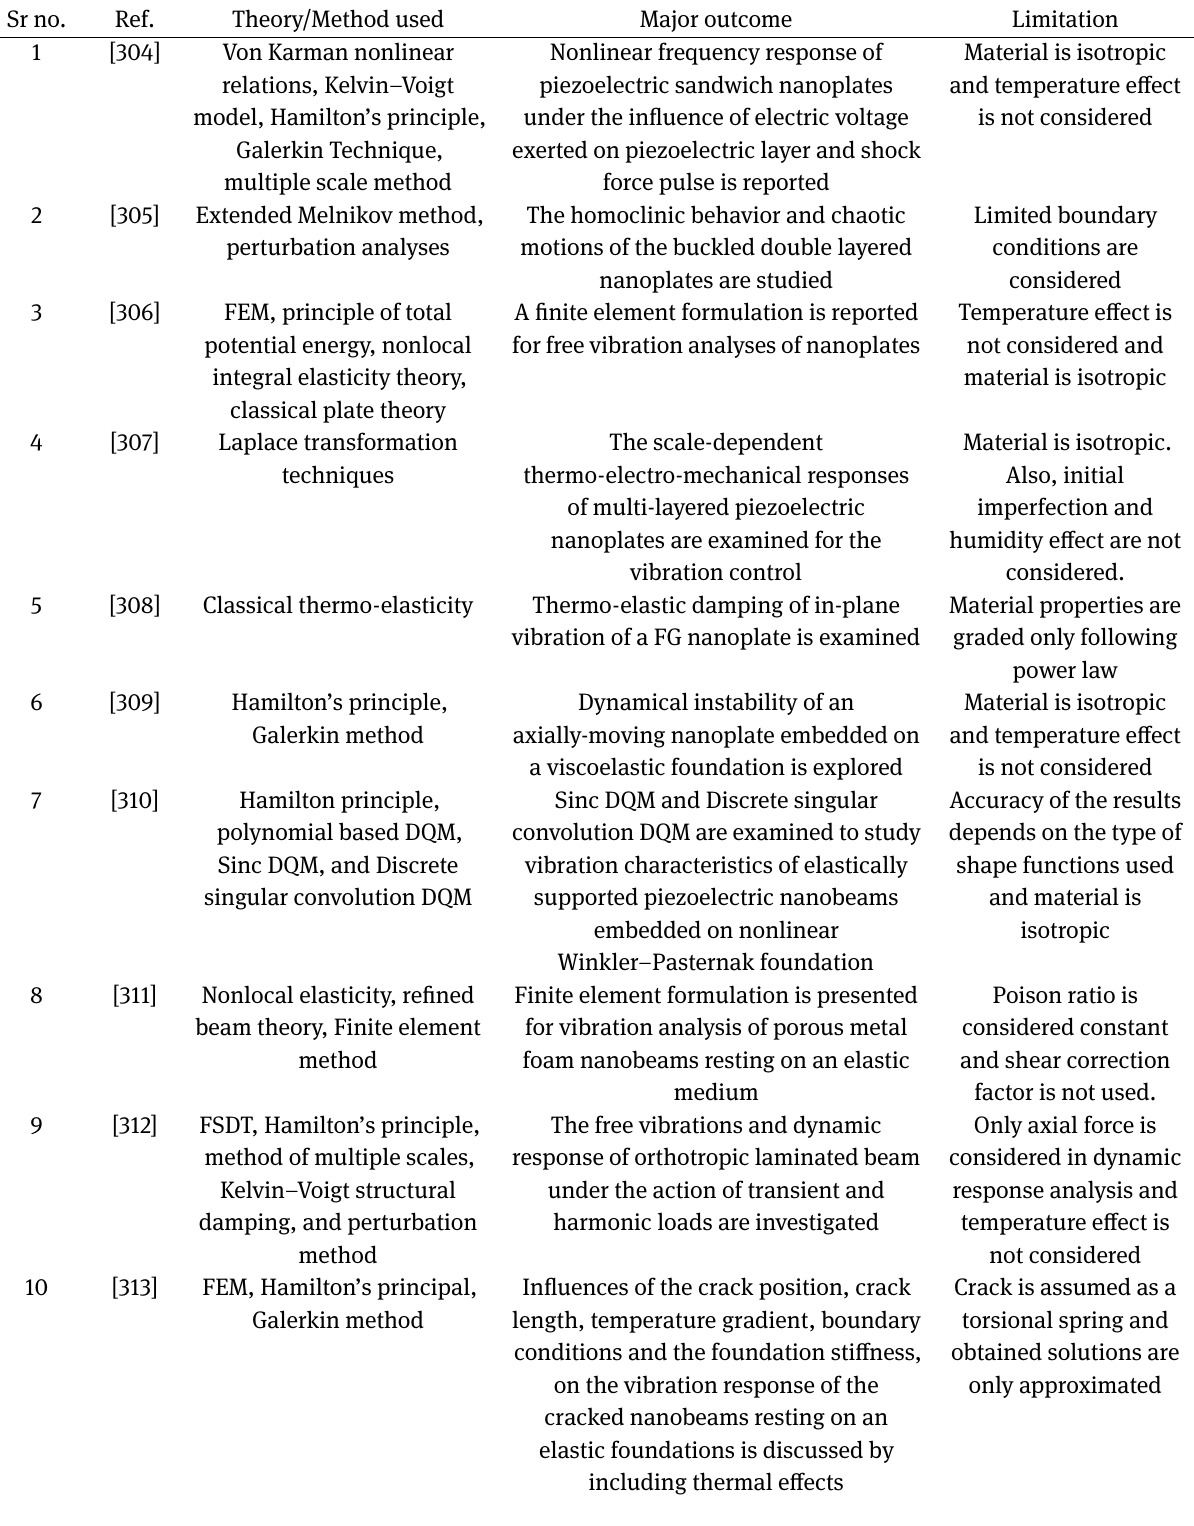
Table 4: Representation of published articles on vibration analysis of nanobeams/nano plates/nanoshells Sr no.